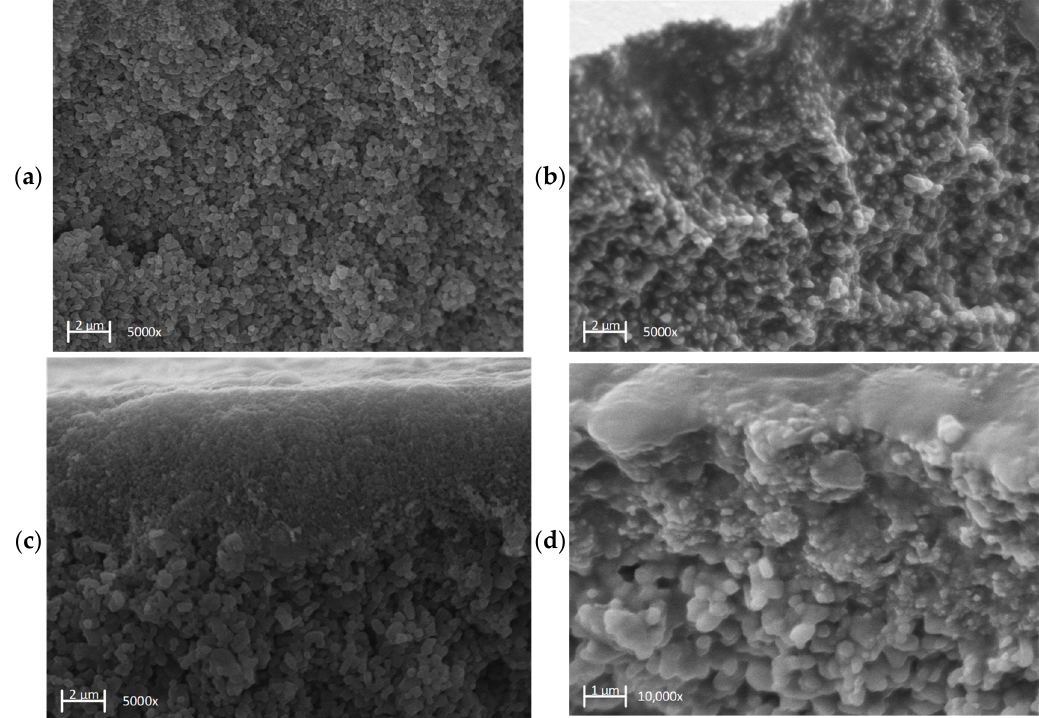
Figure 10. SEM images of the fractured edge of the tubular UF membranes 7C_s and 7C_r in clean and fouled conditions, the latter after the filtration of fermentation broth. ( a ) First separation layer of the clean 7C_s membrane. ( b ) First separation layer of the fouled 7C_s membrane. ( c ) First and second separation layers of the clean 7C_r membrane. ( d ) First and second separation layers of the fouled 7C_r membrane.